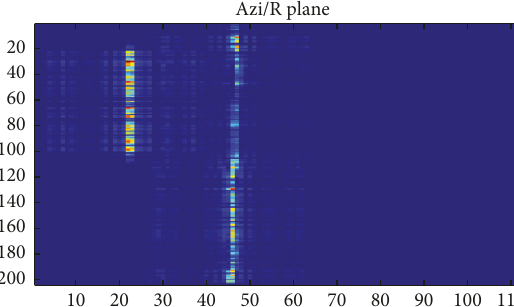
Figure 15: Azimuth-range plane.